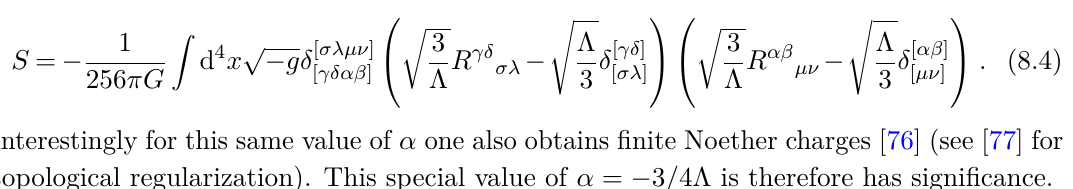
Figure 3 . Here we choose parameter values: k = 1 , Λ = 3 , and α = − 3 transition amplitude G ( a 1 ) given in eq. (8.3) as a 1 =